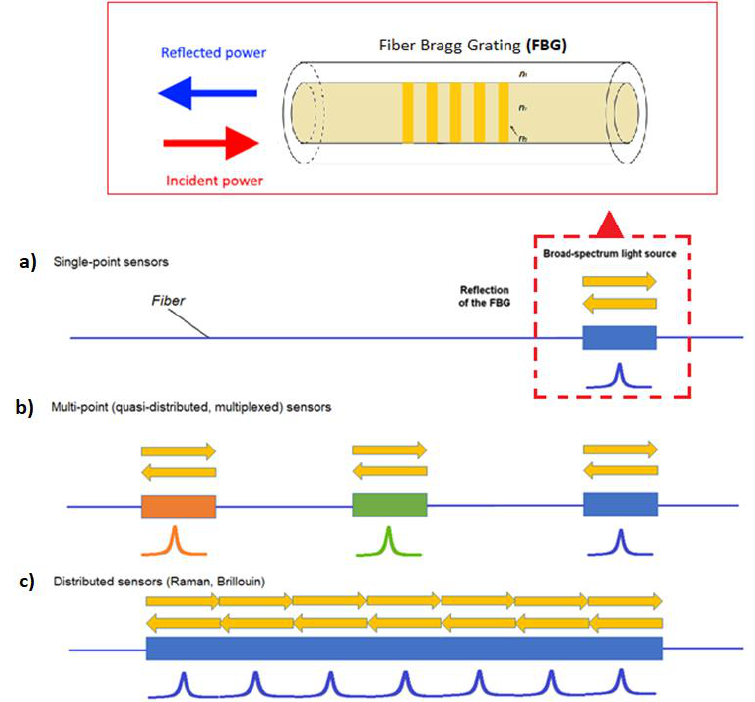
Figure 2. Fibre-optic strain sensing categories: single-point sensors, including ( a ) FBG sensors, ( b ) quasi distribute (multiplexed), and ( c ) distributed sensors.